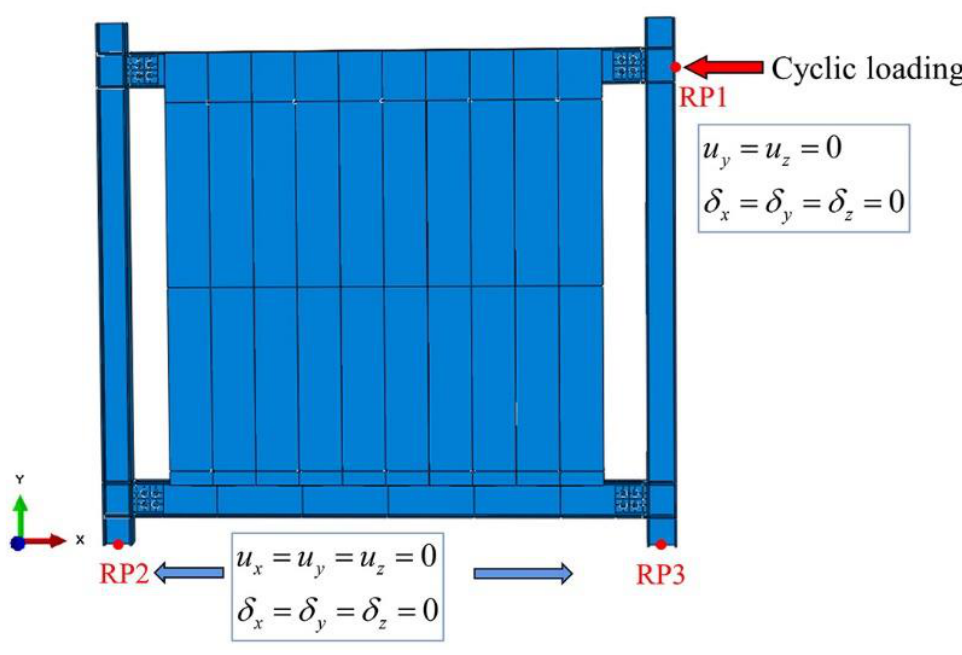
Figure 14. Loads and boundary conditions.